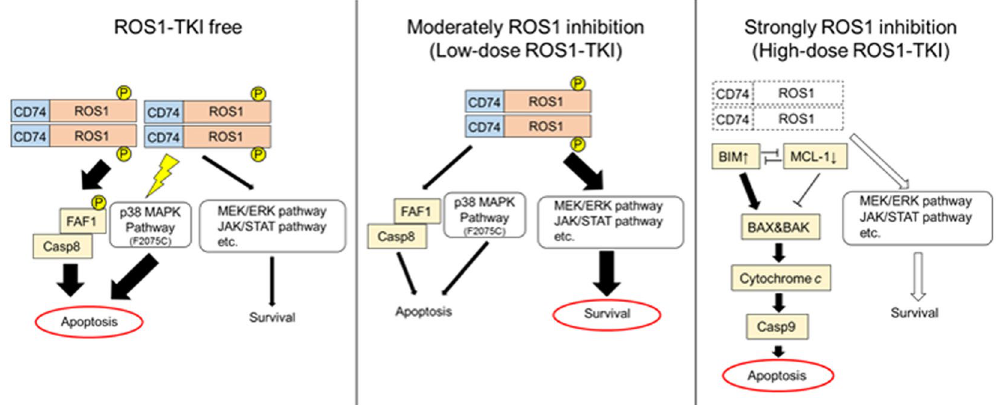
Figure 8. Schematic of cell survival or cell death defined by the intensity of ROS1 activity. (Left) In the absence of a TKI, mutated CD74-ROS1-expressing cells have the potential for excessive activation of ROS1, so that apoptotic signaling is more intense than survival and growth signaling because of excessive ROS1 signaling, that is, when ROS1 activity is not inhibited. (Middle) Cells survive and grow when the intensity of ROS1 activity is moderately inhibited by low-dose ROS1-TKI. (Right) Cells mainly undergo mitochondria originated initiated apoptosis when ROS1 activity is completely inhibited by high-dose ROS1-TKI